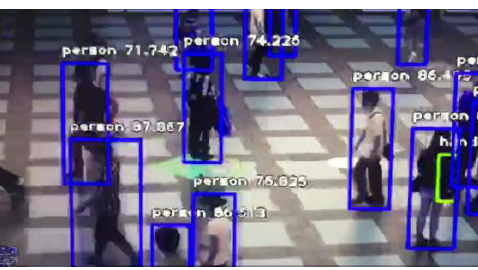
Figure 6. Sensing terminals.